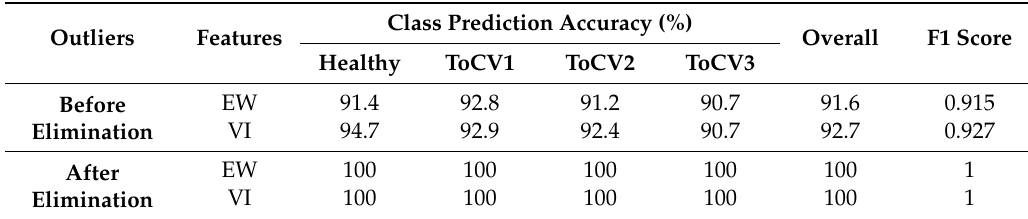
Table 6. Multilayer Perceptron with Automated Relevance Detection (MLP-ARD) classifier prediction performance of the detection of ToCV on the tomato plants and its severity before outlier elimination. Class 1 represents the healthy state and classes 2–4 the severity of the disease in an increasing order, denoted as